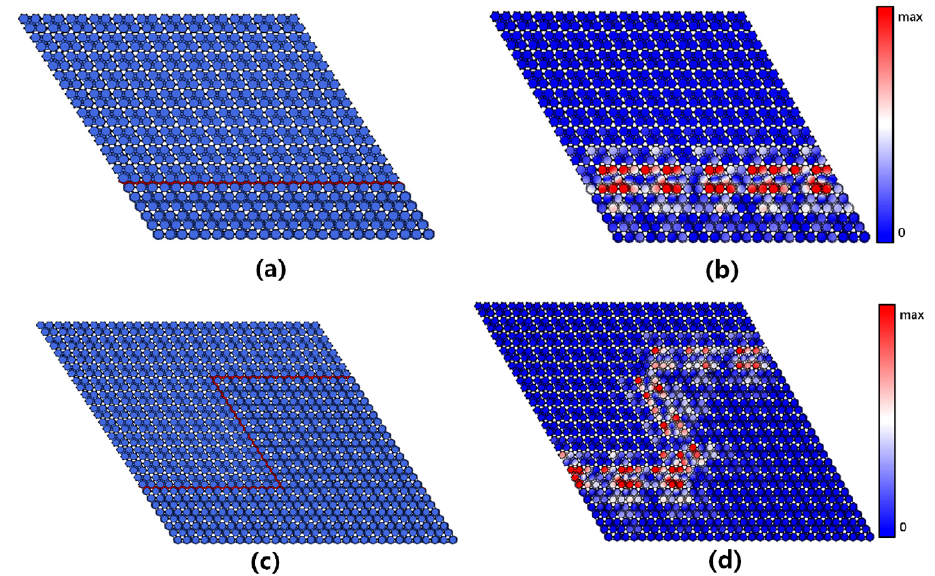
Figure 6. ( a ) Schematic diagram of the linear waveguide; ( b ) Topological transport of elastic waves in the linear waveguide; ( c ) Schematic diagram of the Z-shaped waveguide; ( d ) Topological transport of elastic waves in the Z-shaped waveguide.